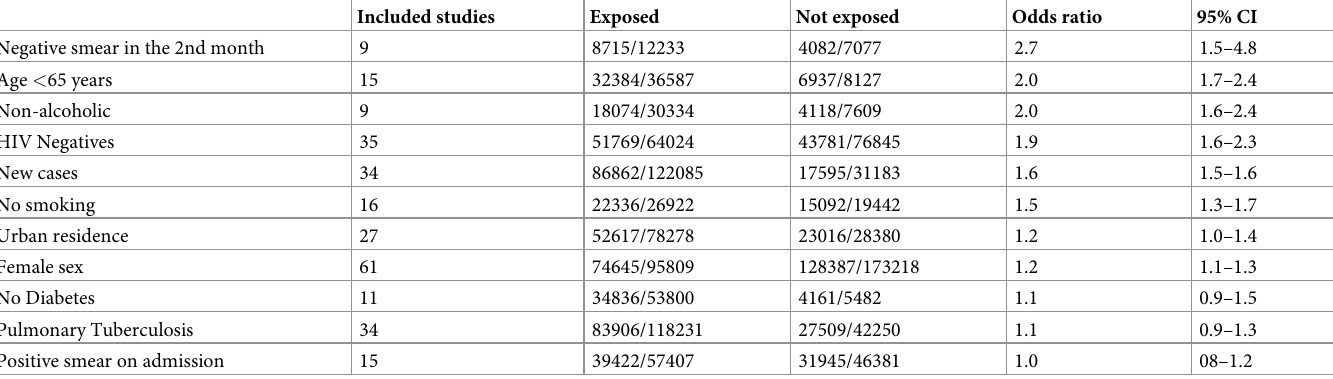
Table 4. Factors predictive of favorable outcomes of tuberculosis